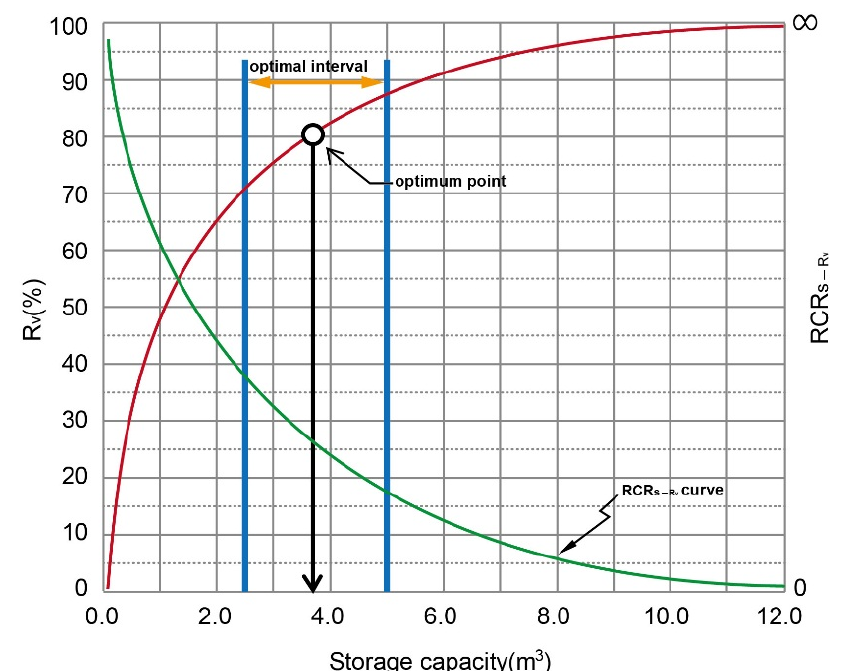
Figure 5. R v vs. storage capacity